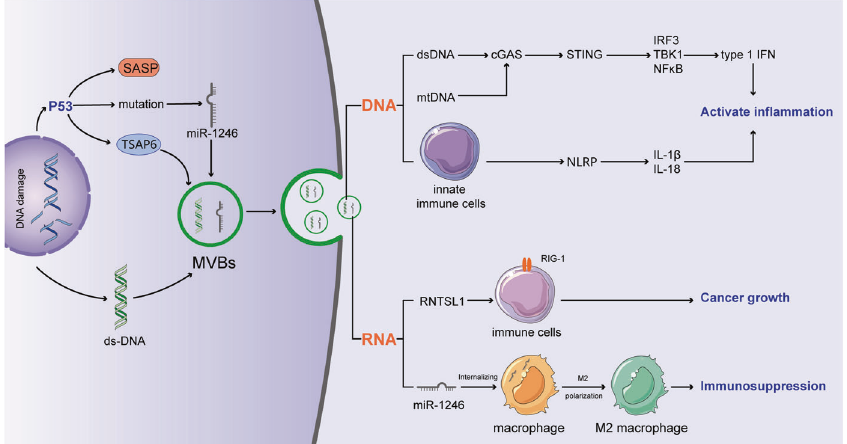
Fig. 3 DNA damage stress induced the release of immunomodulatory cargoes through EVs. In DDR, P53 activated the tumor suppressor- activated pathway 6 (TSAP6) to increase the secretion of exosomes. Additionally, mutant P53 can selectively increase the release of miR-1246- enriched exosomes. And these miR-1246-enriched exosomes contribute to anti-in fl ammatory immunosuppression by inducing high levels of TGF- β activity. As a stress reaction, senescence enhanced the biosynthesis of exosome-like vesicles, and further several highly reactive agents were liberated via EVs. When cellular DNA damages appeared, EVs secretion contributed to maintain intercellular homeostasis via excreting the harmful cytoplasmic DNA fragments. dsDNA and mtDNA can upregulate the expressions of type I IFNs by activating cGAS/STING pathway. Additionally, exoDNA can be absorbed by innate immune cells in the intestine to stimulate the activation of the in fl ammasome and then enhance the secretion of IL-18 and IL-1 β . RN7SL1 activates RIG-I in immune cells to accelerate the tumor growth. Importantly, dsRNA is deemed as a contributor of anti-cancer immunity since it recruits T cells into the tumor microenvironment through increasing the secretion of TLR3-dependent cytokines including type I IFN and CXCL10.